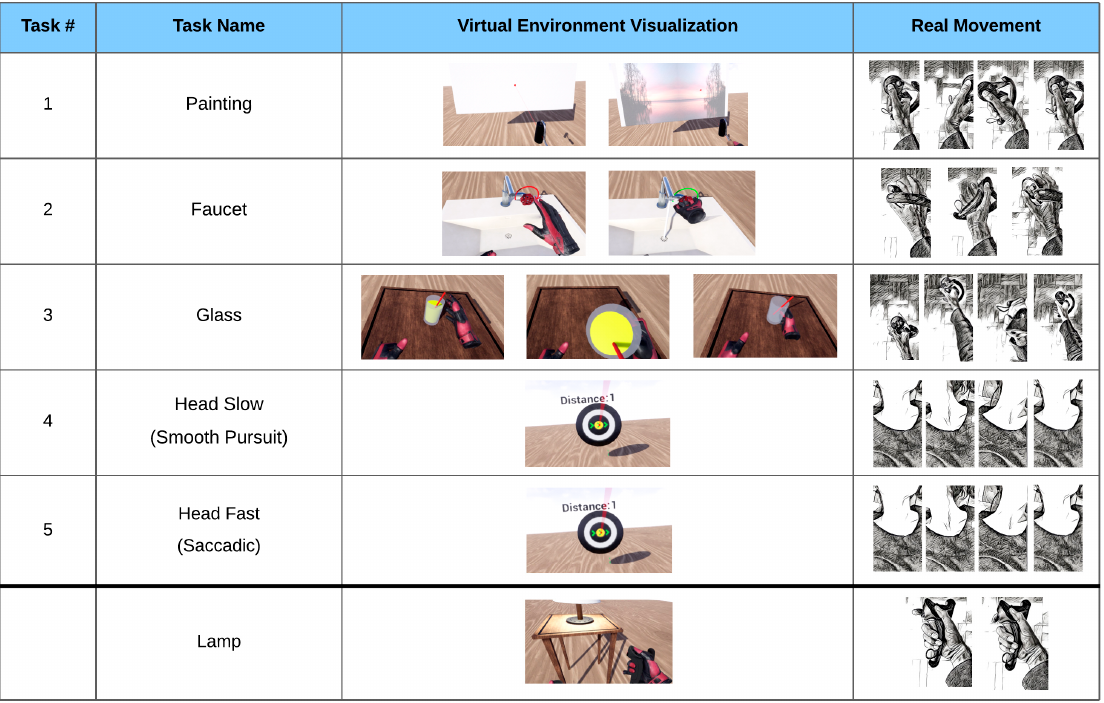
Figure 1. The five tasks with VR visualization and movement depiction. Painting: wrist extension, followed by flexion, followed by extension. Faucet: forearm supination of >20 ◦ , followed by a pronation. Glass: a complex movement consisting of an elbow extension, a grasp, elbow flexion, elbow extension, and a release of the grasp. Head Slow: smooth pursuit of the head while tracking a target moving to the right, then left, then right. Head Fast: saccadic movement of the head toward a target appearing to the right, then left, then right. Lamp: button press with the index finger or thumb (only included in EMG